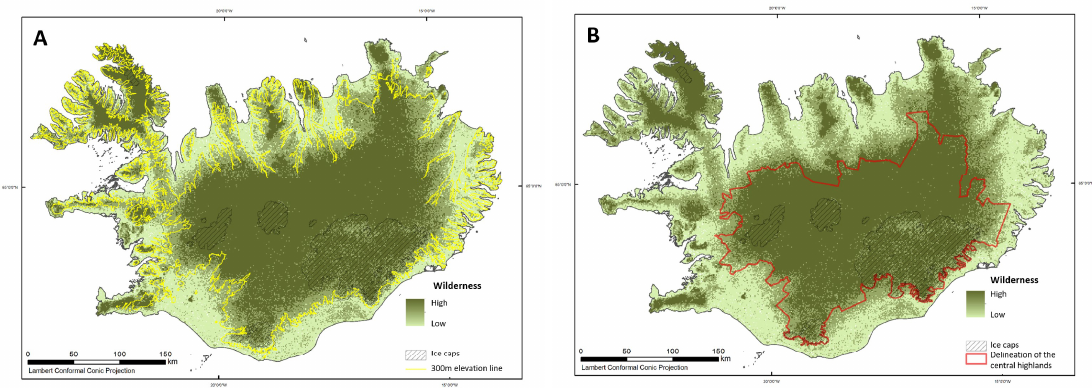
Figure 8. The Map-me results of the scope of perceived wilderness in Iceland compared to the 300 m elevation line (( A ) yellow line), and the central highlands boarders (( B ) red line).